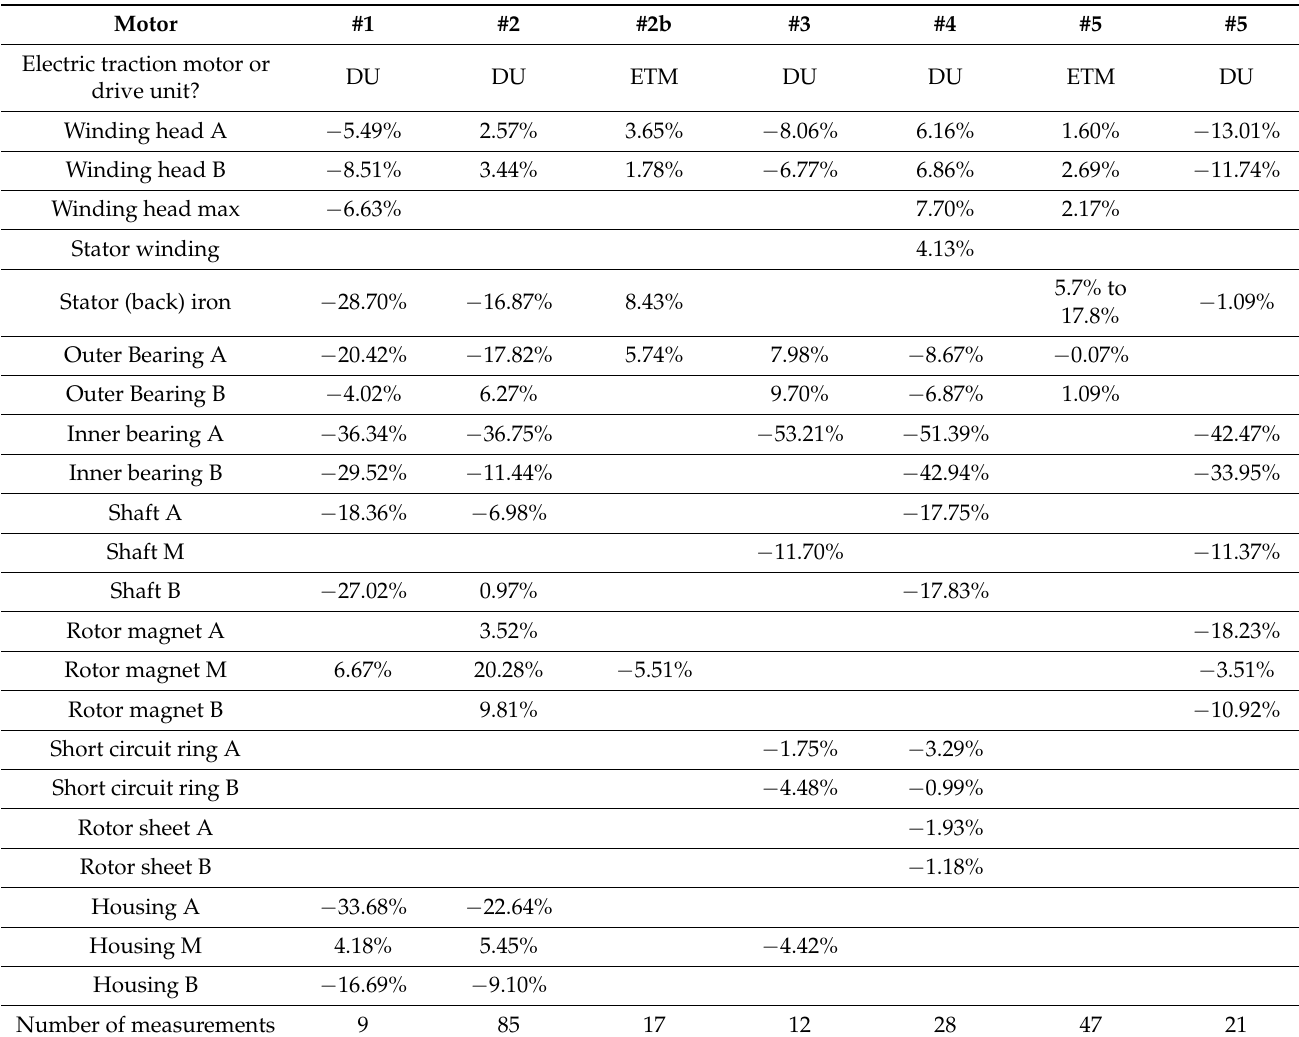
Table 5. Mean relative errors for stationary operating points of different electric traction motors and drive